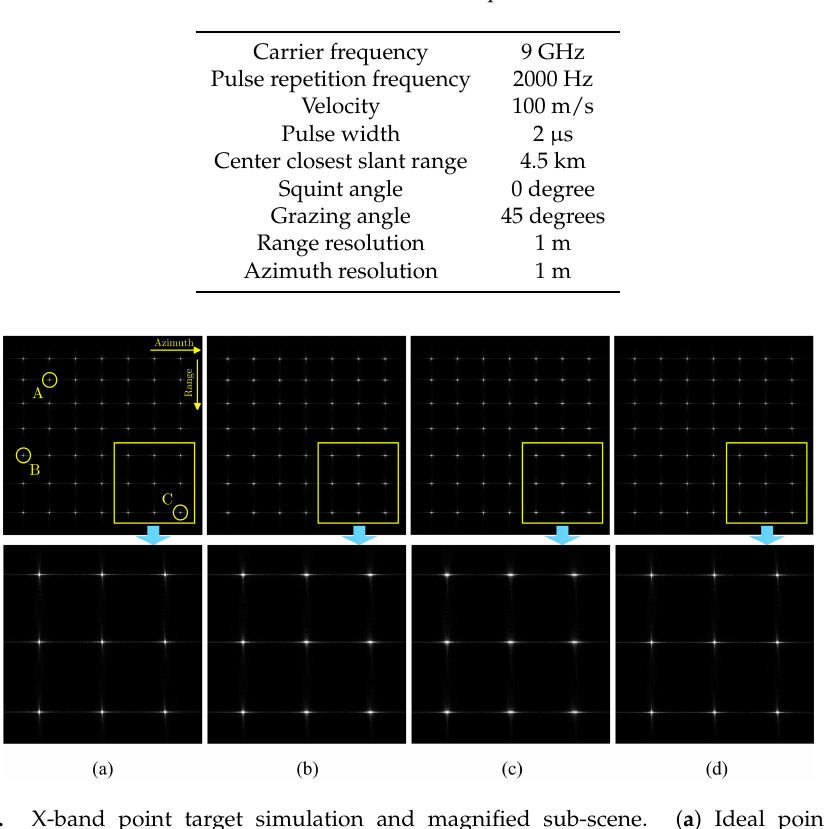
Table 2. X-Band simulation parameters.